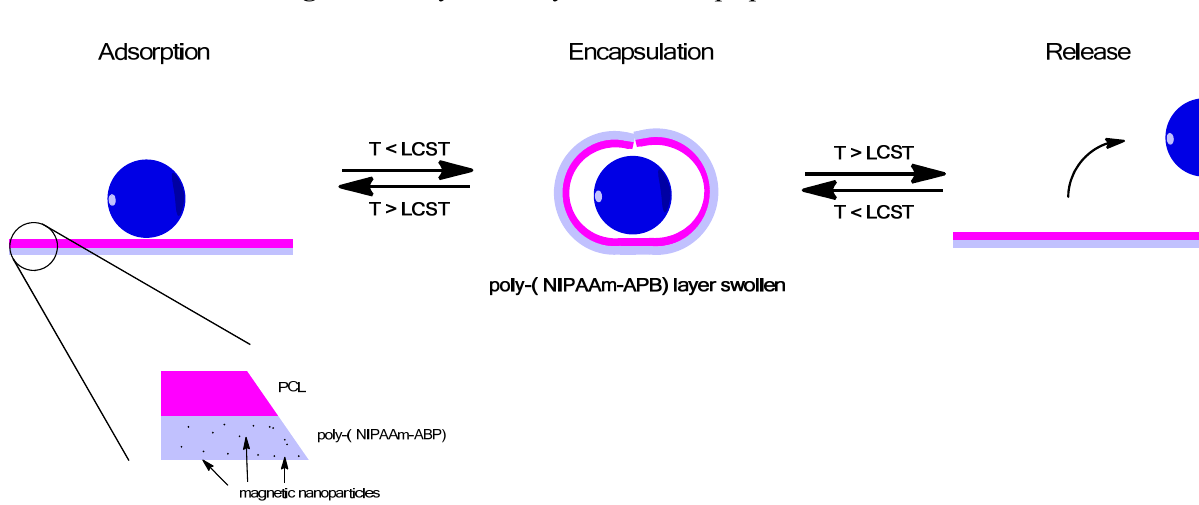
Figure 9. Polymer bilayer film entraps particles and